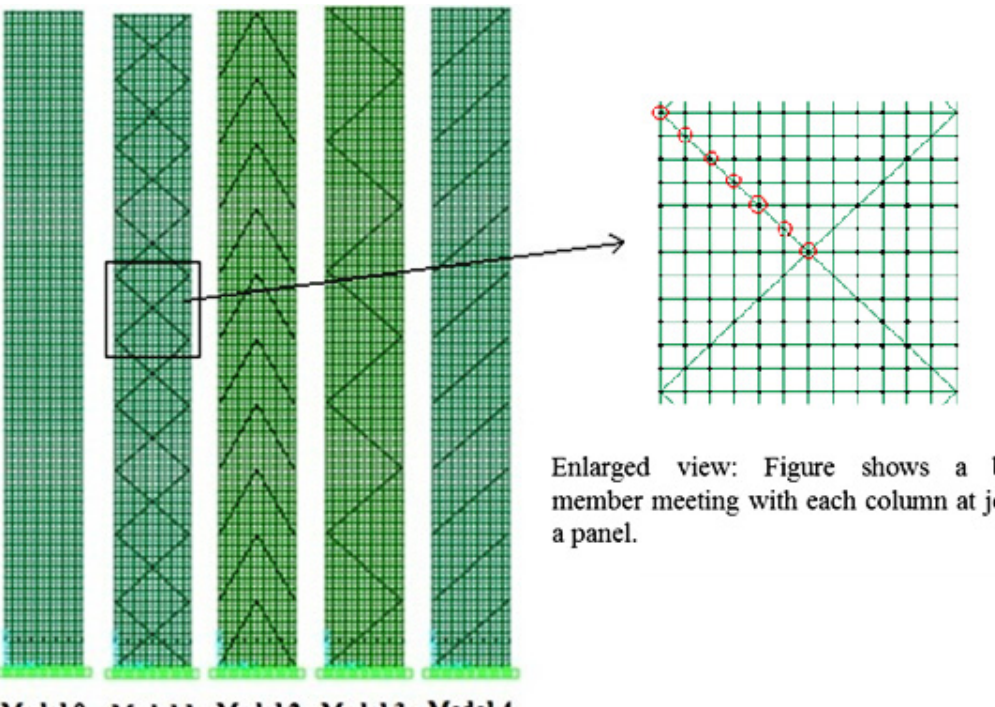
Figure 7. Bracing systems of different patterns considered in this study. Bracing angle is 45° from horizontal. Only 120 story high buildings are shown.